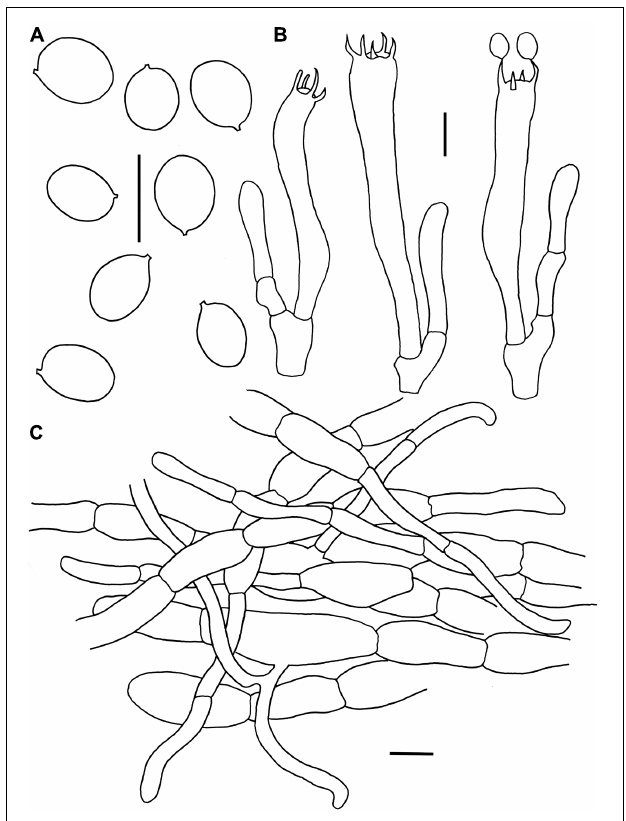
FIGURE 9 | Microscopic features of Craterellus parvopullus (FHMU6555, holotype). (A) Basidiospores. (B) Basidia. (C) Pileipellis. Scale bars = 10 µ m. Drawings by Y.Z.